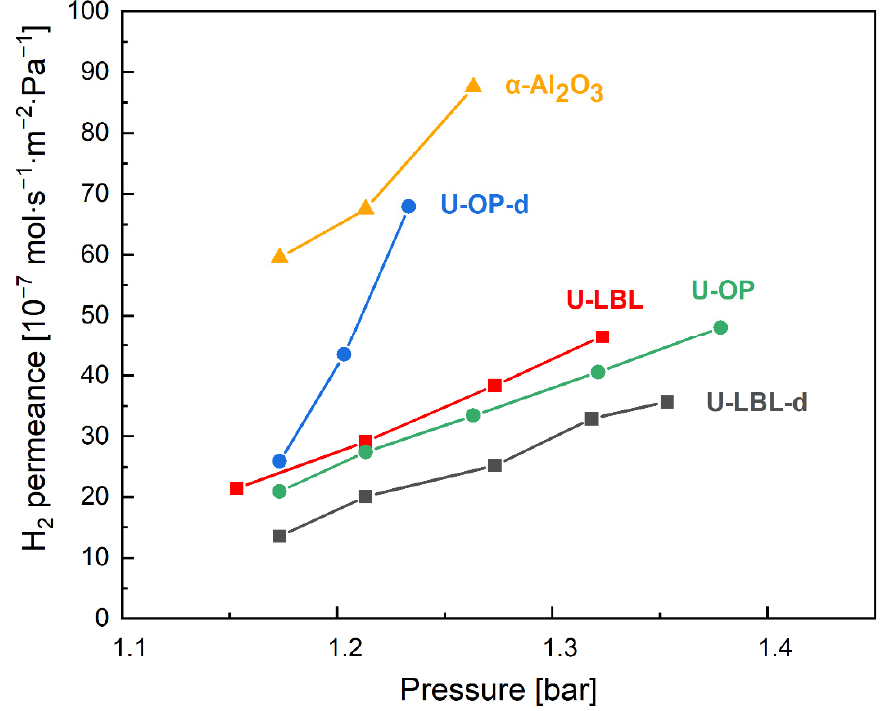
Figure 7. H 2 permeance of the membranes from permeation test results conducted with increasing feed absolute pressure at room temperature.